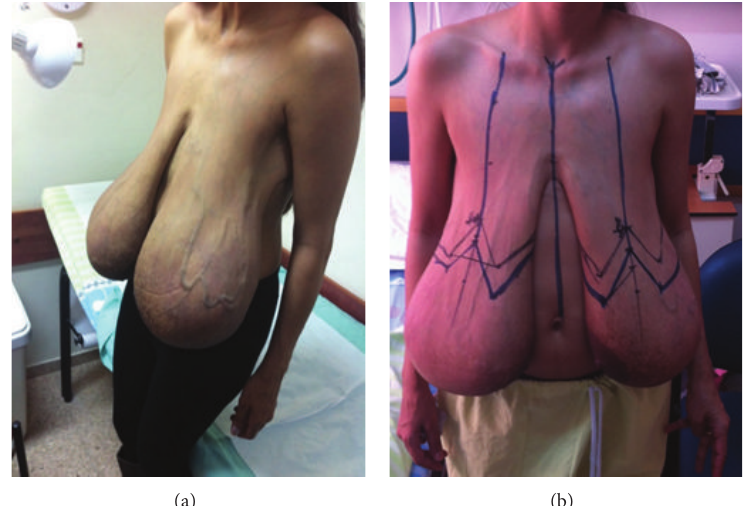
Figure 1: Pre-operative view. Extreme breast ptosis with medial rotation of nipple-areola complex.